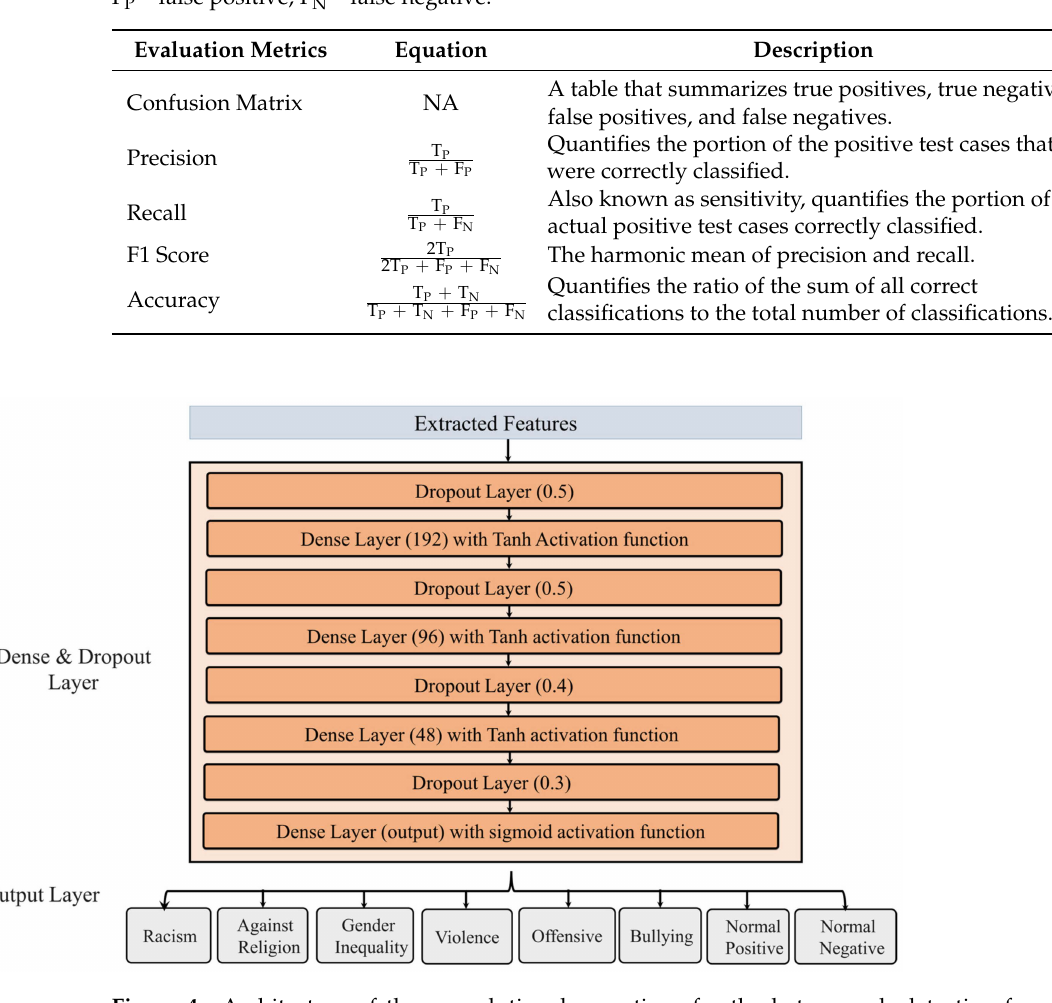
Table 3. Evaluation metrics used for the experimental results. T P —true positive; T N —true negative; F P —false positive; F N —false negative.